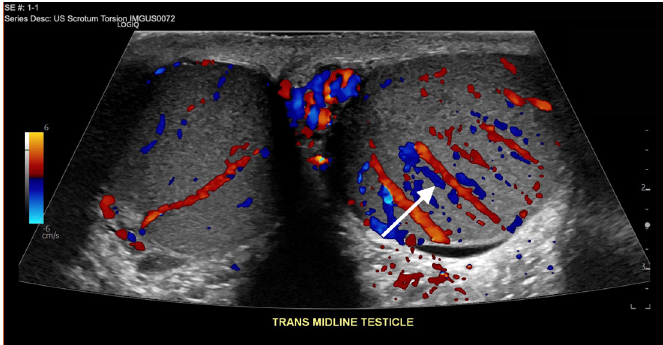
Image 3. Comprehensive ultrasonographic side-by-side view of testicles after manual detorsion. The image-right corresponds to the patient’s left testicle, which demonstrated hyperemia likely related to detorsion event highlighted by the included arrow. Surrounding edema over affected testicle is also